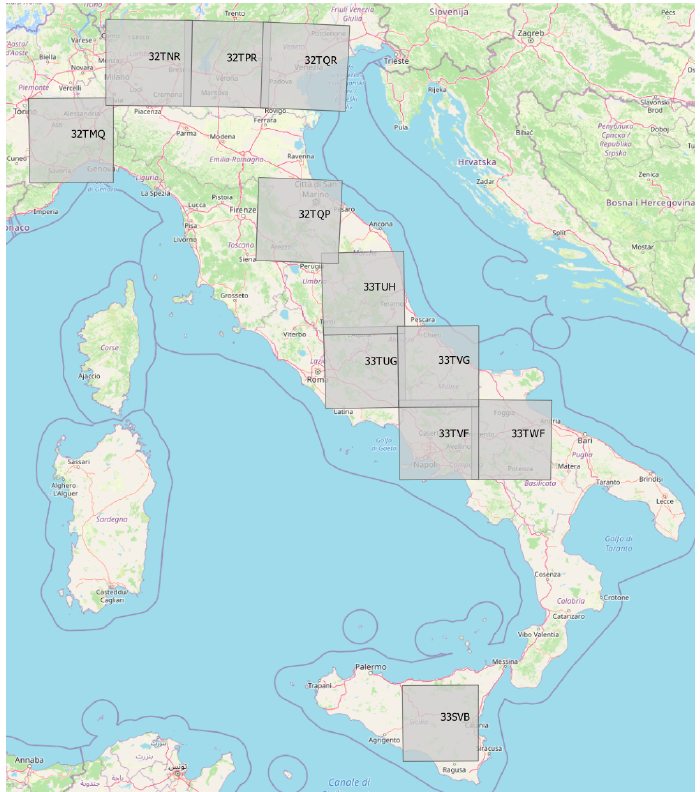
Figure 5. Localization of the Sentinel-2 tiles used in dataset